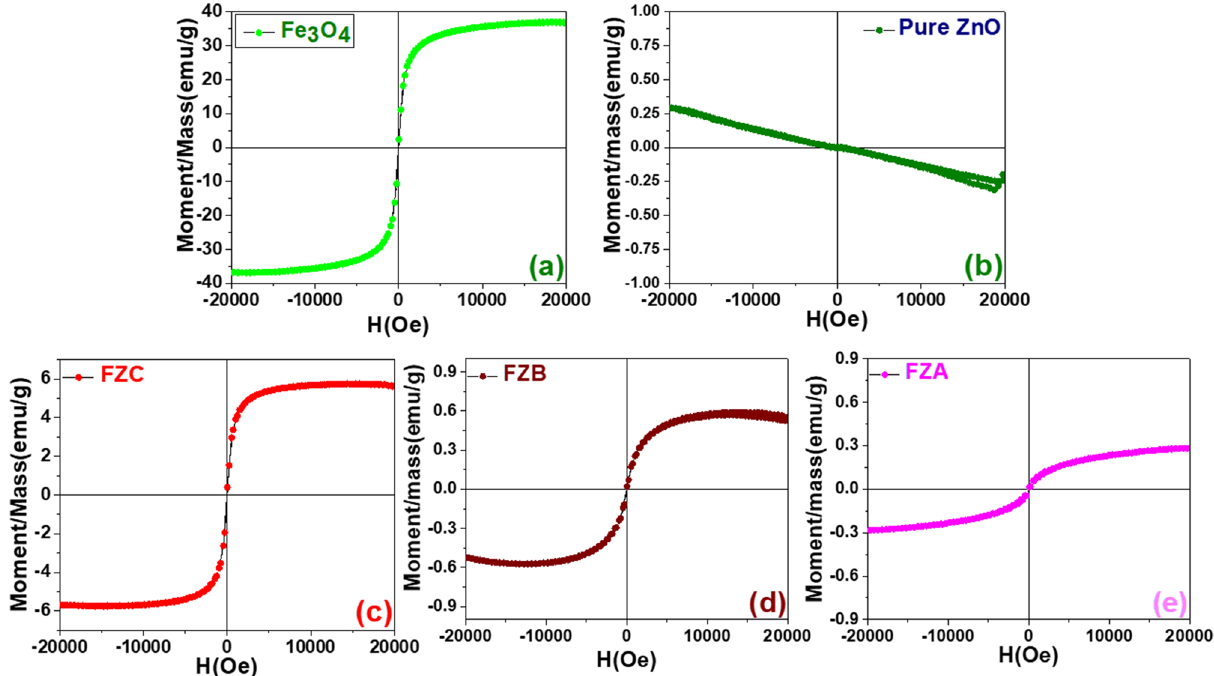
Figure 6. Room temperature dc magnetic measurement curves of ( a ) FN, ( b ) ZN, ( c ) FZC ( d ) FZB, ( e ) FZA